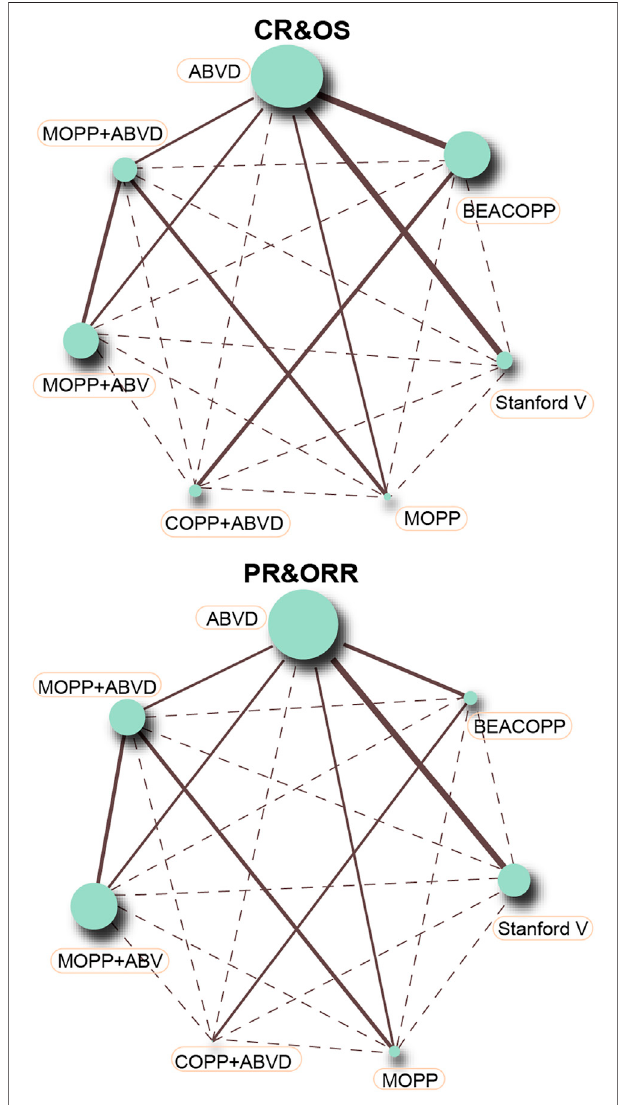
FIGURE 2| CR, PR, ORR, and OS in advanced HL patientstreated with different chemotherapy regimens (each node represented an intervention, node sizes implicated sample sizes, and the thickness of lines connecting any two nodes signi fi ed the number of included studies).